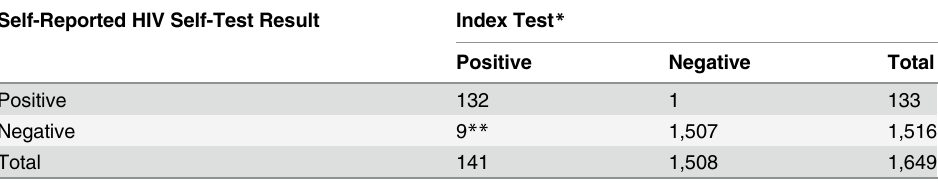
Table 3. Summary of quality assurance process and accuracy